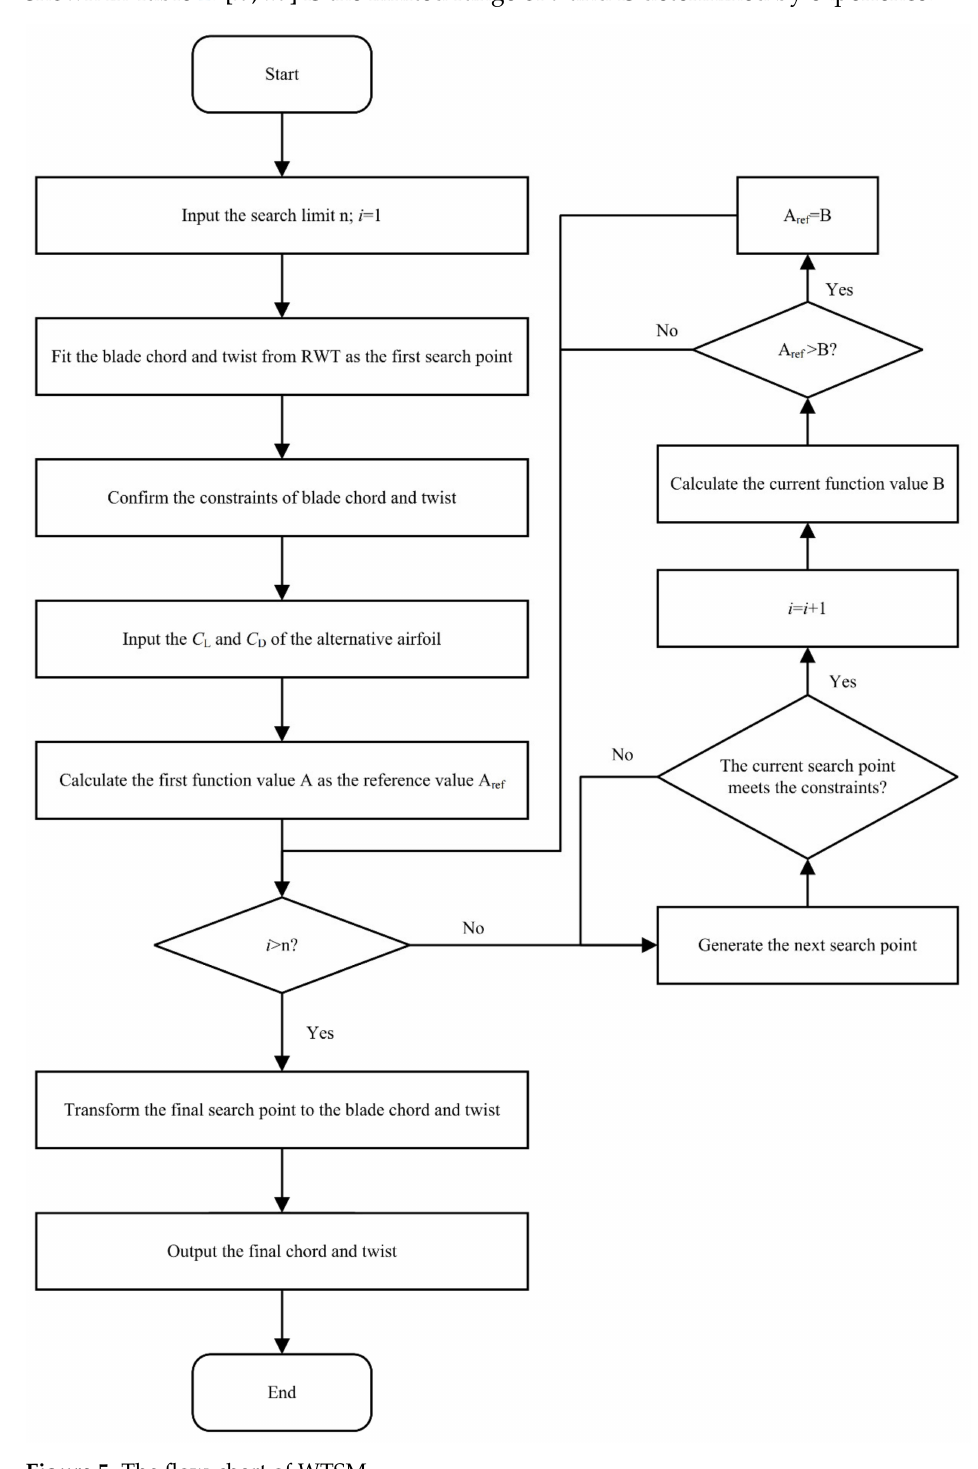
Figure 5. The flow-chart of